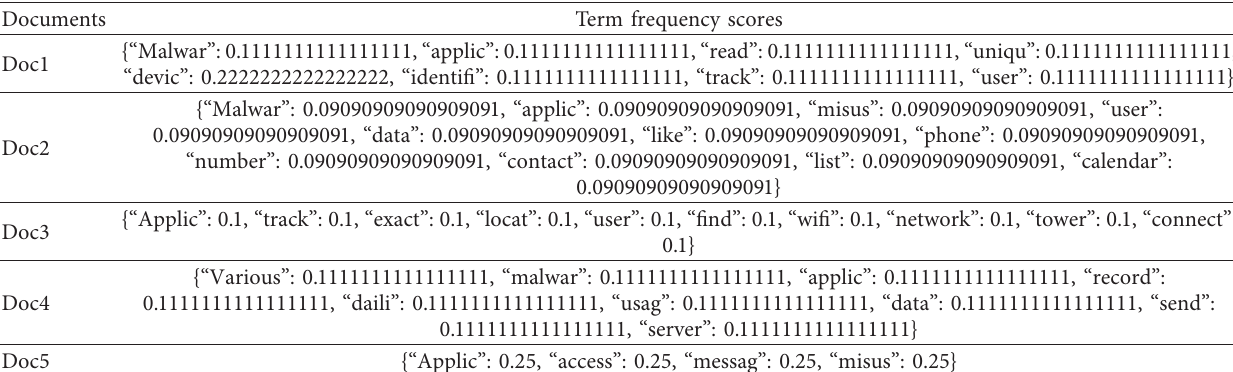
Table 4: Term frequency scores for each